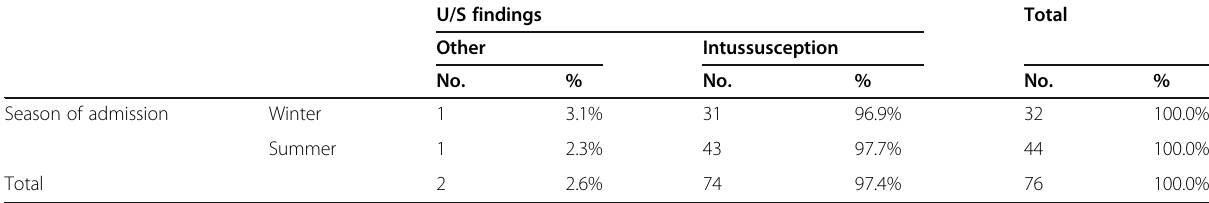
Table 1 Summer vs